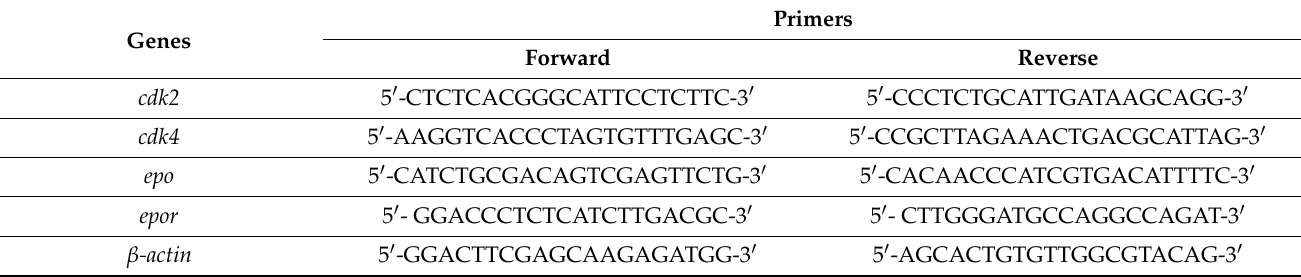
Table 2. Primer information for